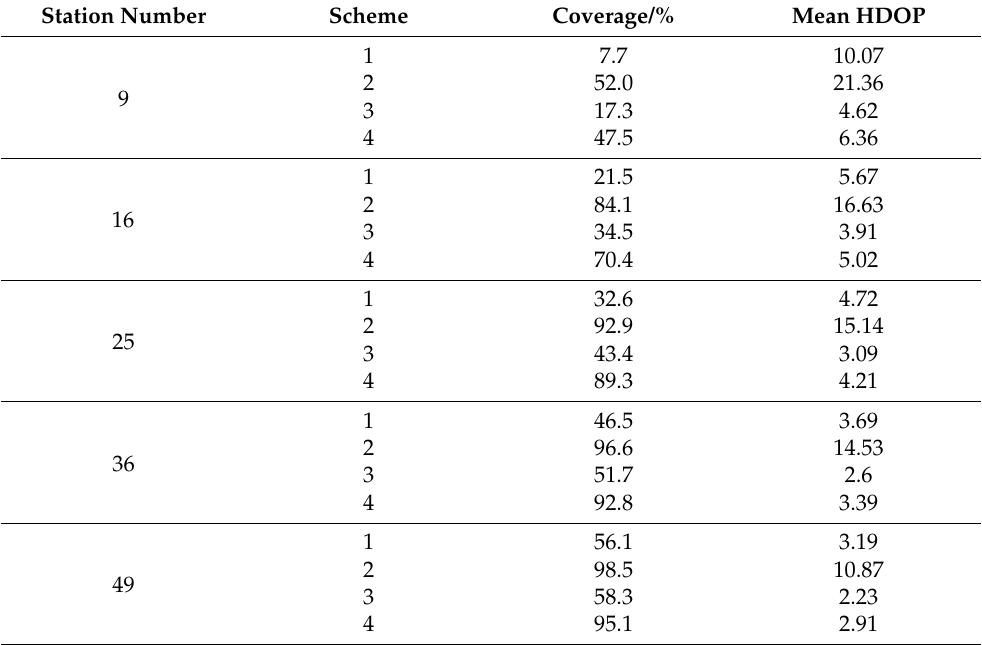
Table 1. Coverage, mean HDOP, and the number of pseudolite stations under the four schemes.